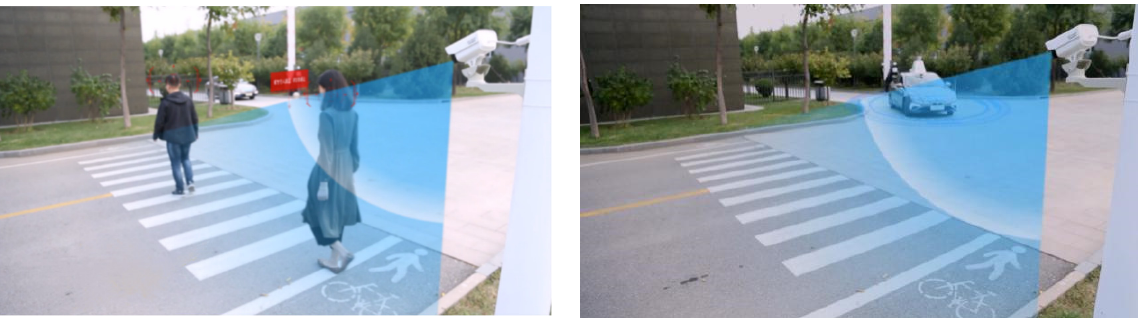
Figure 25. Pedestrian recognition and avoidance based on V2X.